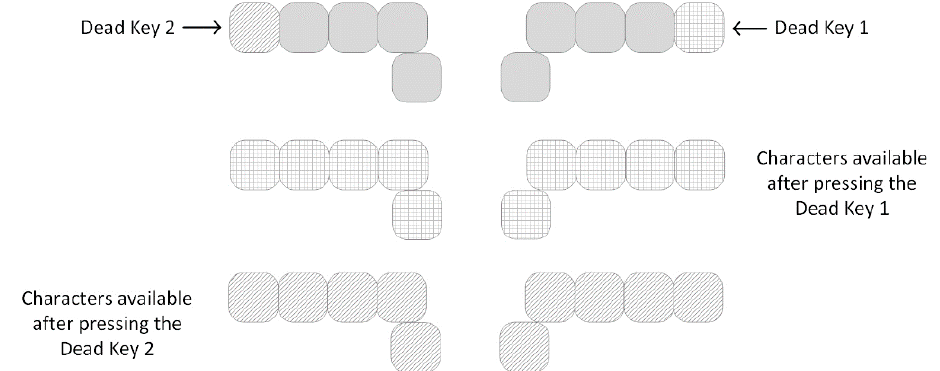
Figure 4. Schematic presentation of keyboards with two dead keys.